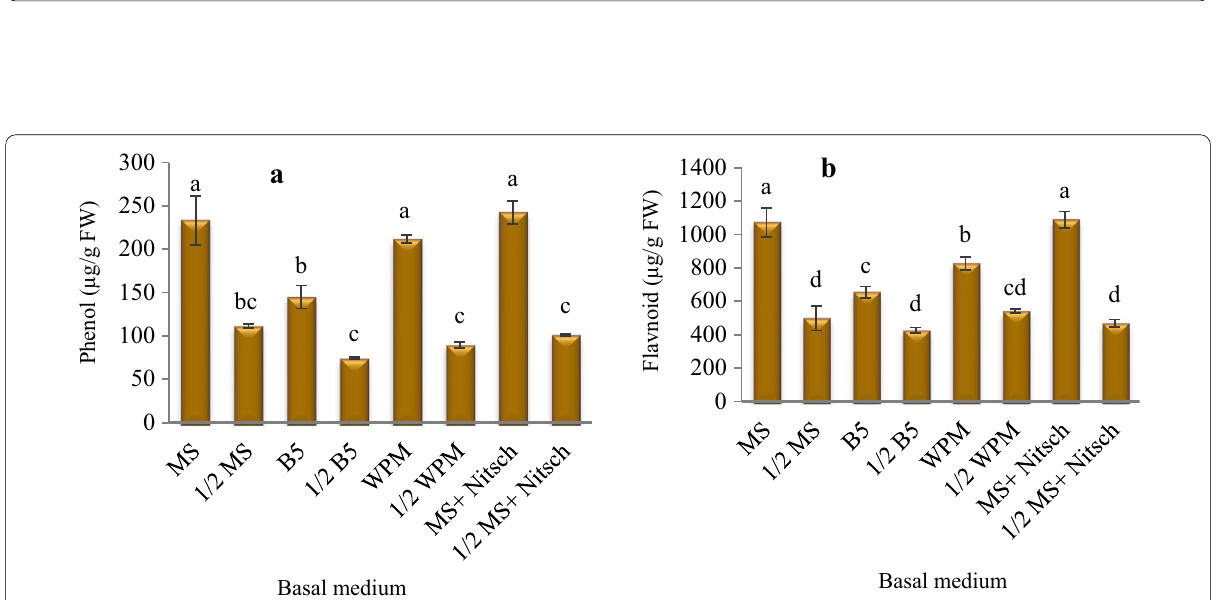
Fig. 6 The effect of basal medium on the amount of H 2 O 2 ( a ) and MDA ( b ) in the Corylus avellana callus cultures. According to Duncan’s multiple range tests, values with common letters are not significantly different at the 5% probability level